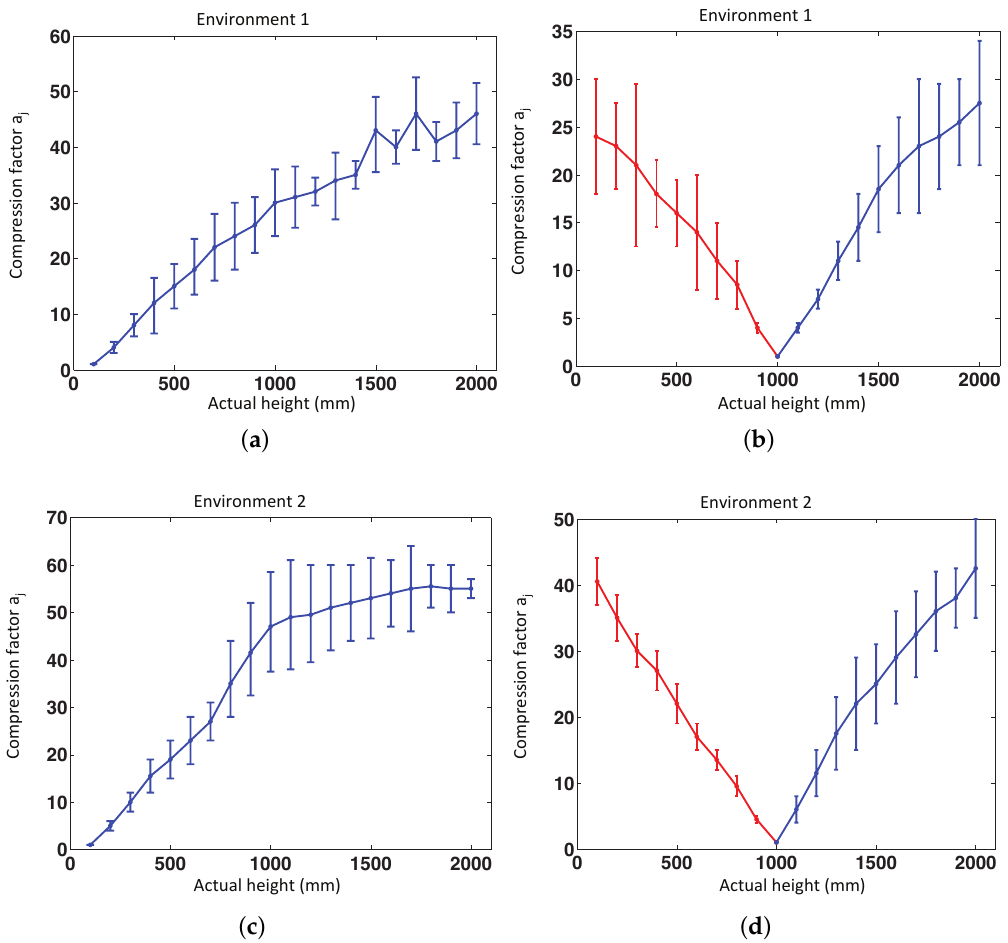
Figure 14. ( a ) Experiments in Virtual Environment 1 with the reference image at height = 100 mm. ( b ) Experiments in the environment 1 with the reference image at 1000 mm. ( c ) Experiments in the virtual environment 2 with the reference image at 100 mm. ( d ) Experiments in Environment 2 with the reference image at 1000